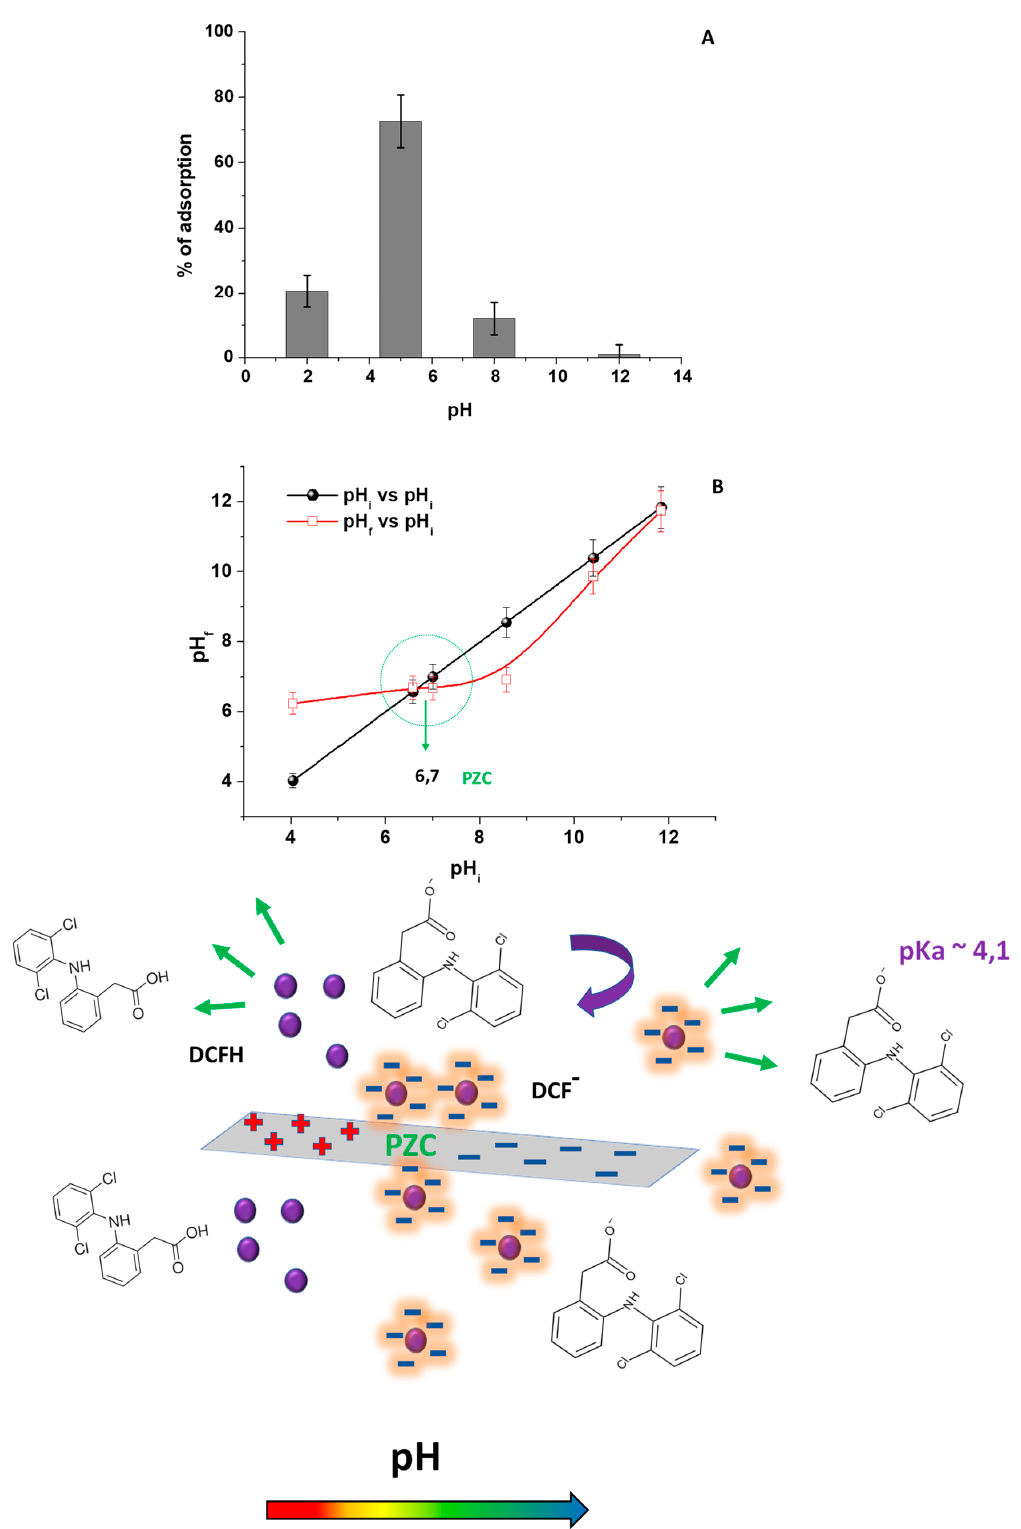
Figure 2. ( A ) The percentage of DCF adsorption (considering 120 min as contact time) onto chitosan film (Film 2) at several pH values (from a DCF solution 1.50 × 10 − 5 M). ( B ) The determination of the pH PZC of the chitosan film by using the drift method. The cartoon reported in the figure depicts the nature of interaction between DCF and CH, by changing the pH values. The violet spheres represent the DCF